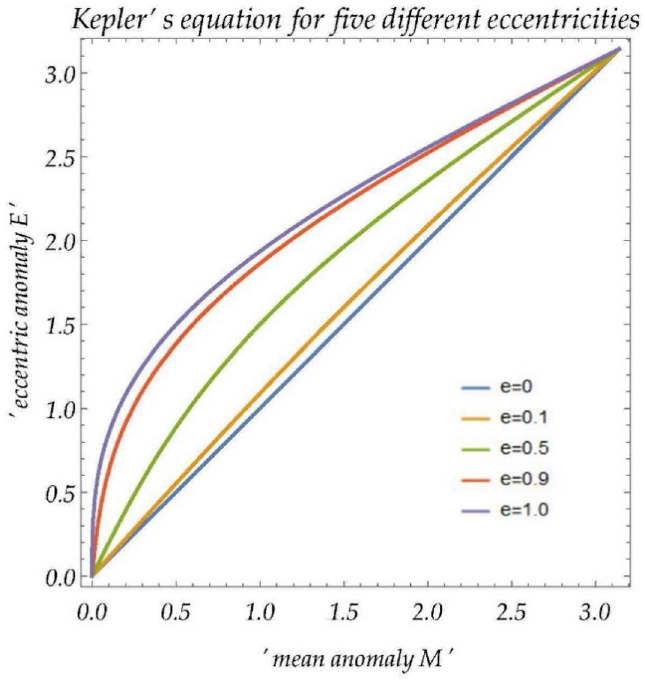
Figure 1. Contours of the Kepler’s equation with different eccentricities ( e = 0, 0.1, 0.5, 0.9, 1